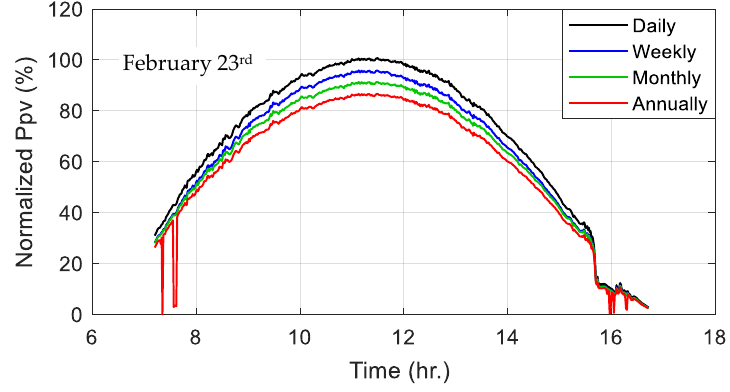
Figure 11. Actual PV data under different cleaning periods (sunny day).